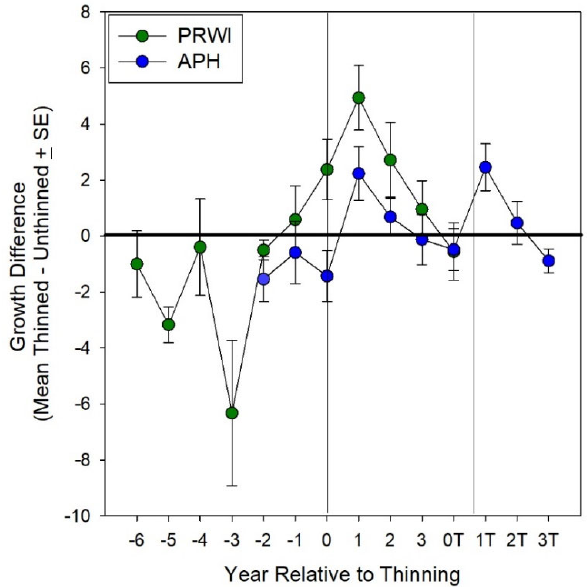
Figure 7. Comparison of plant growth in colonies at Prince William Forest Park (PRWI, green) and Fort A.P. Hill (APH, blue), showing the difference in growth (mean difference between growth ± 1SE) between thinned (or tree death) and un-thinned populations, relative to the year of thinning (treefall for PRWI). The years relative to thinning 0T-3T refer to years 1–3 after a second thinning in these colonies.